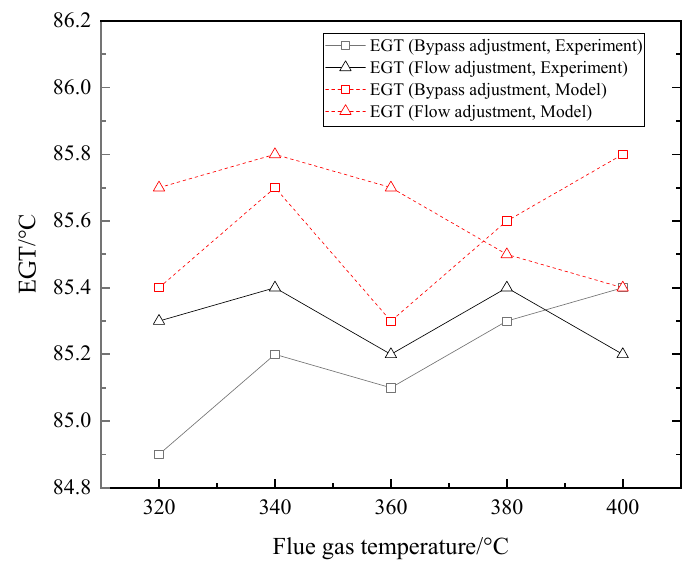
Figure 14. E h and E u as flue gas temperature changed.